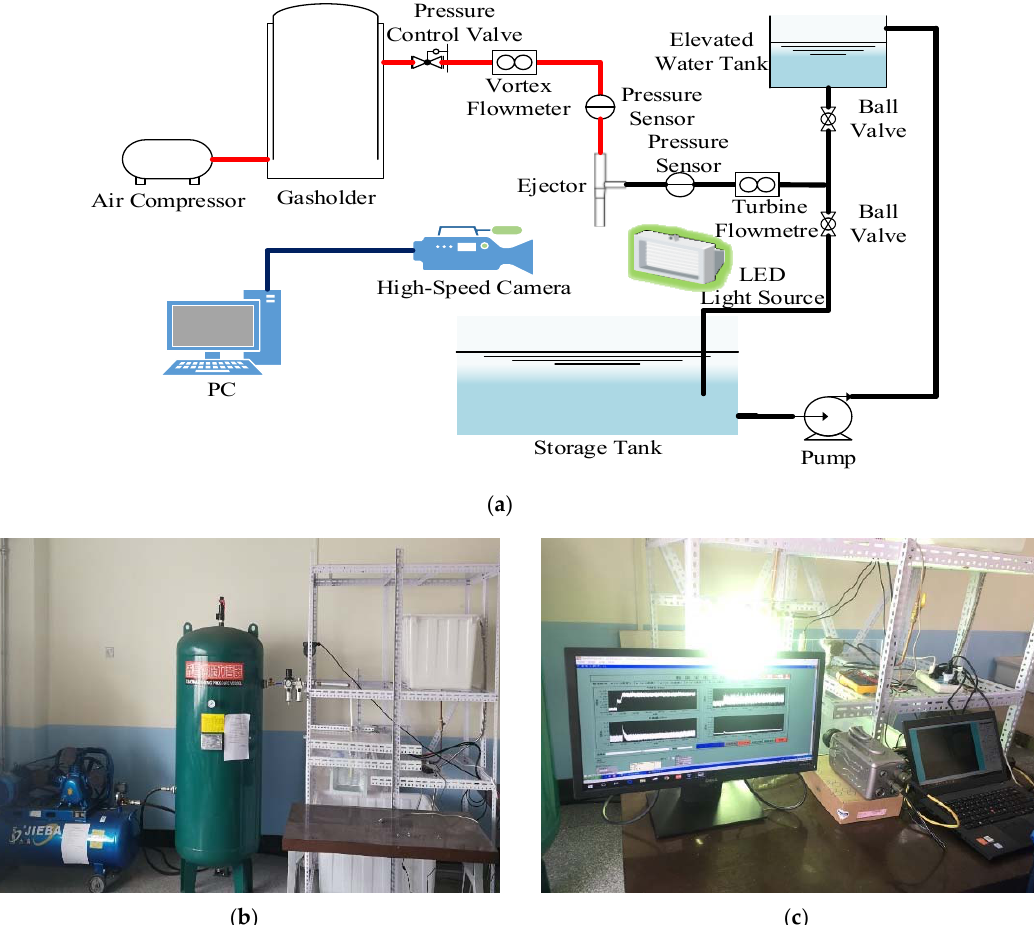
Figure 1. Schematic of the experimental setup. ( a ) the experimental setup; ( b ) the gas and liquid supply system; ( c ) the measurement system.